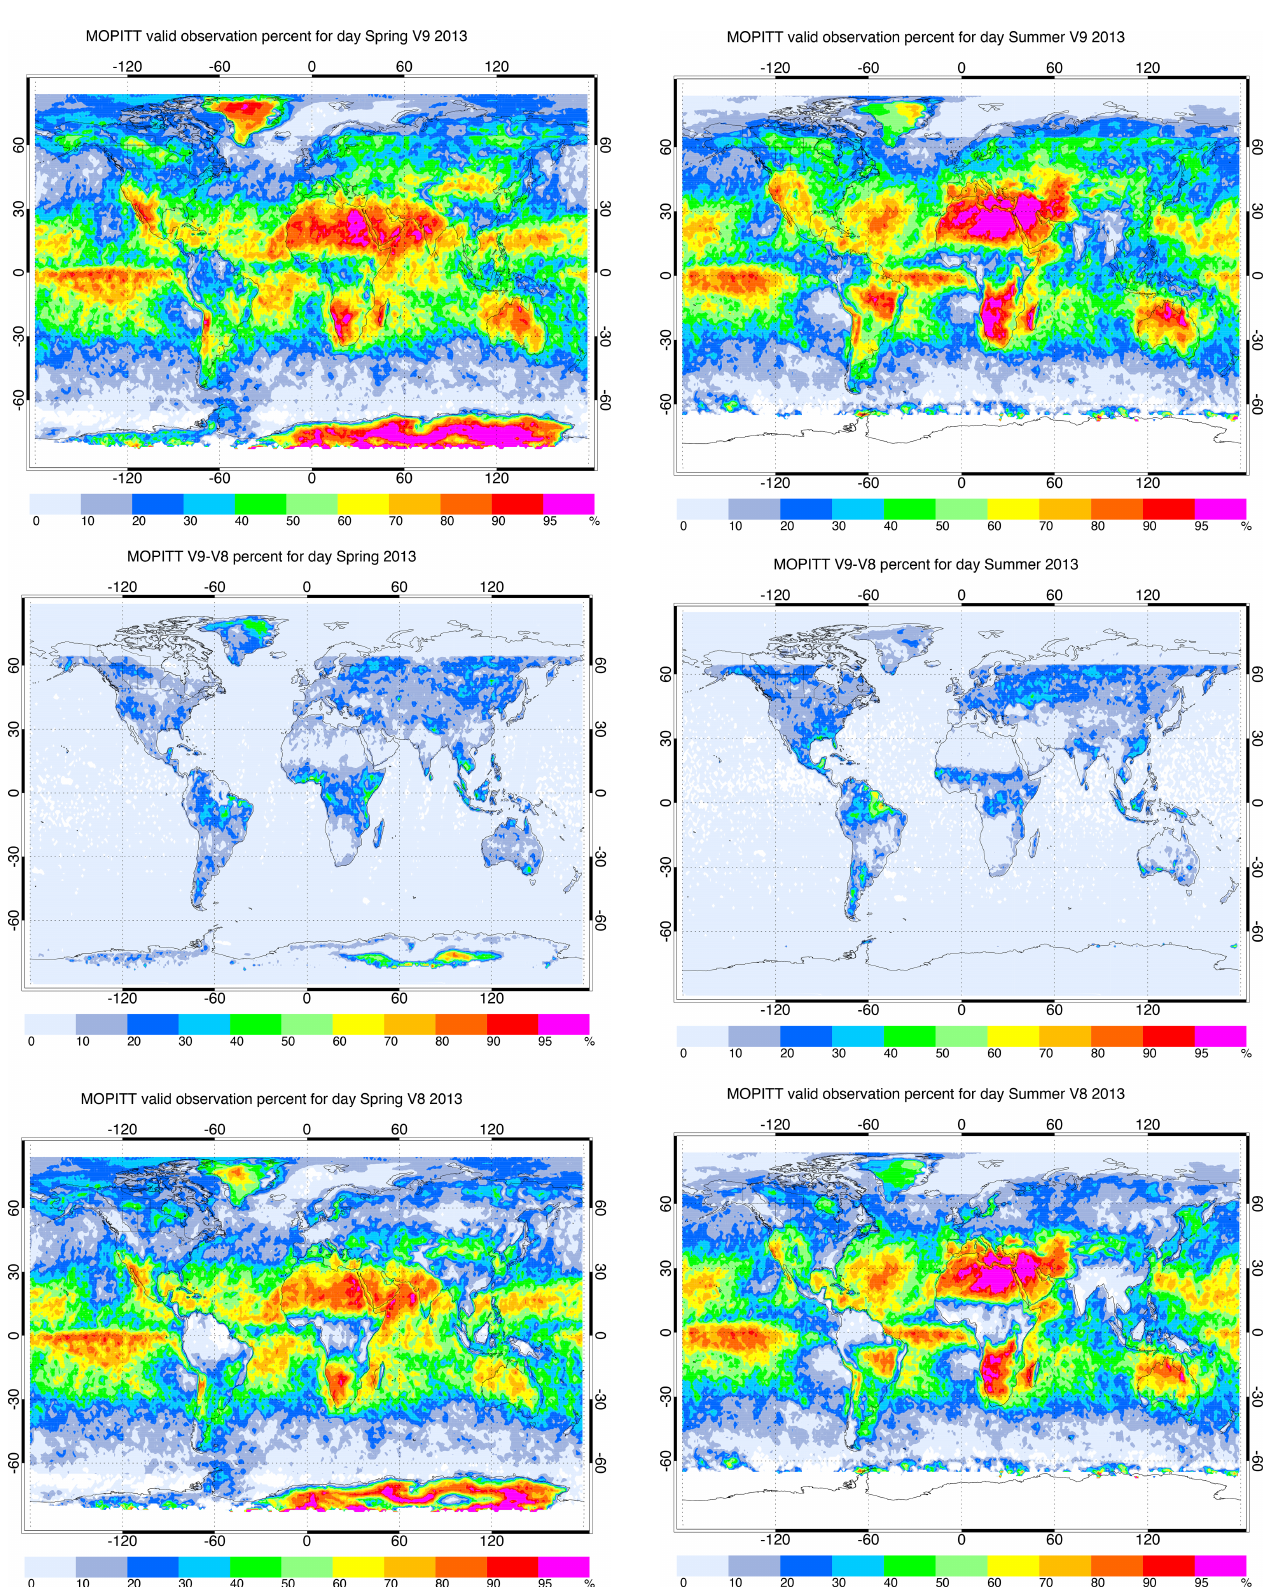
Figure 3. The same as Fig. 2 but for the spring season. Figure 4. The same as Fig. 2 but for the summer